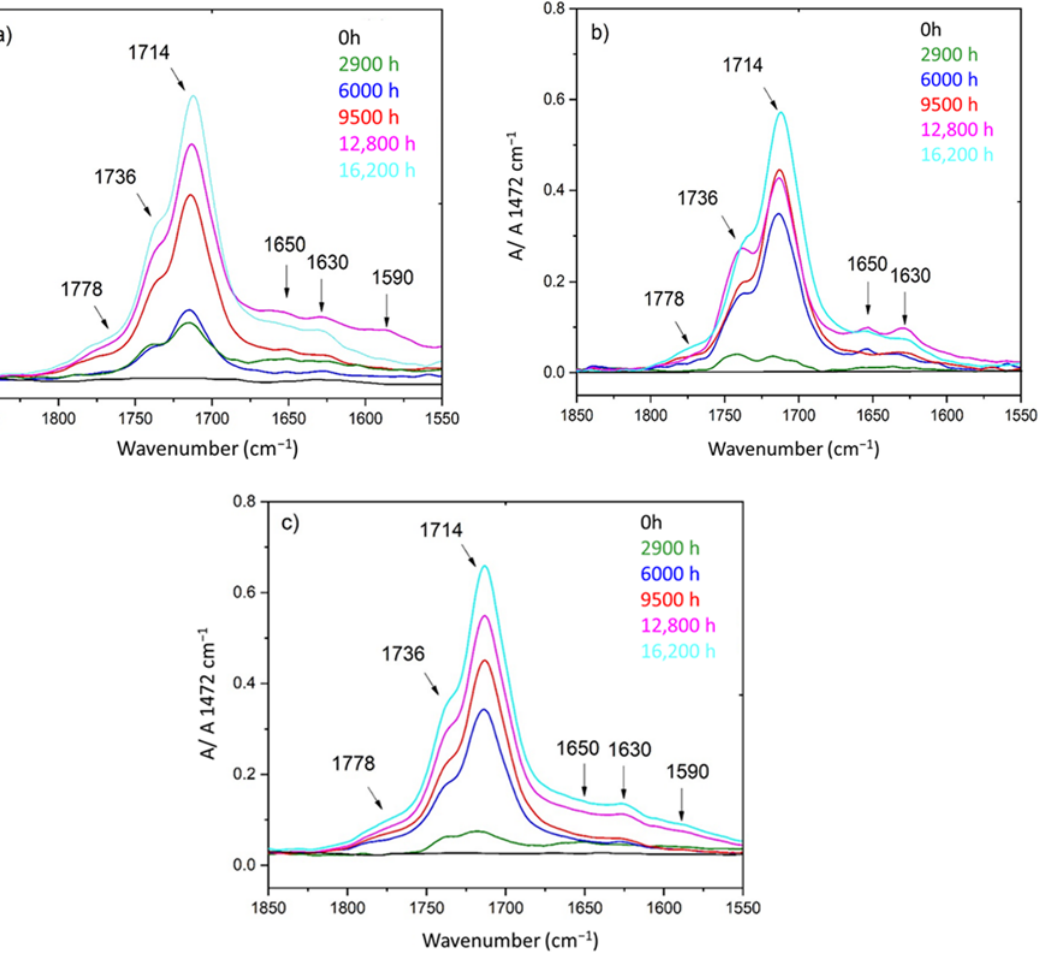
Figure 1. Changes in the FTIR spectrum (obtained in ATR mode) of the Si ‐ XLPE matrix filled with 0 phr ( a ), 25 phr ( b ), and 50 phr ( c ) of ATH, during radio ‐ thermal exposure in air under 8.5 Gy ∙ h − 1 at 47 °C. Table 3. Main degradation products detected by FTIR spectroscopy during the radio ‐ thermal ageing of the Si ‐ XLPE matrix.